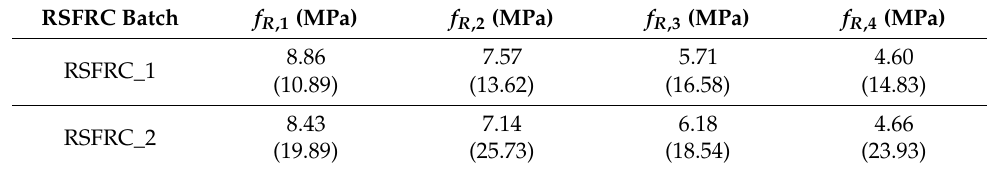
Figure 5. Average force/flexural stress–deflection curves obtained in bending tests of RSFRC_1 and RSFRC_2 batches (120 days). ( a ) Deflection up to 1.5 mm ( b ) Deflection up to 5 mm. Table 4. Average results (and CoV) of 3PNBBT.